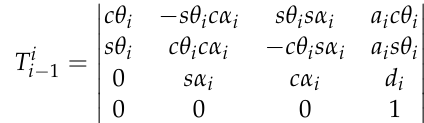
Figure 5. The relationship between the cable length and angle of the NCR. Set the yellow cable as cable 1 and cable 2, the blue cable as cable 3 and cable 4 and the bending radius of each cable as R i . i refers to the i -th cable. There is 45° spacing between the cables.